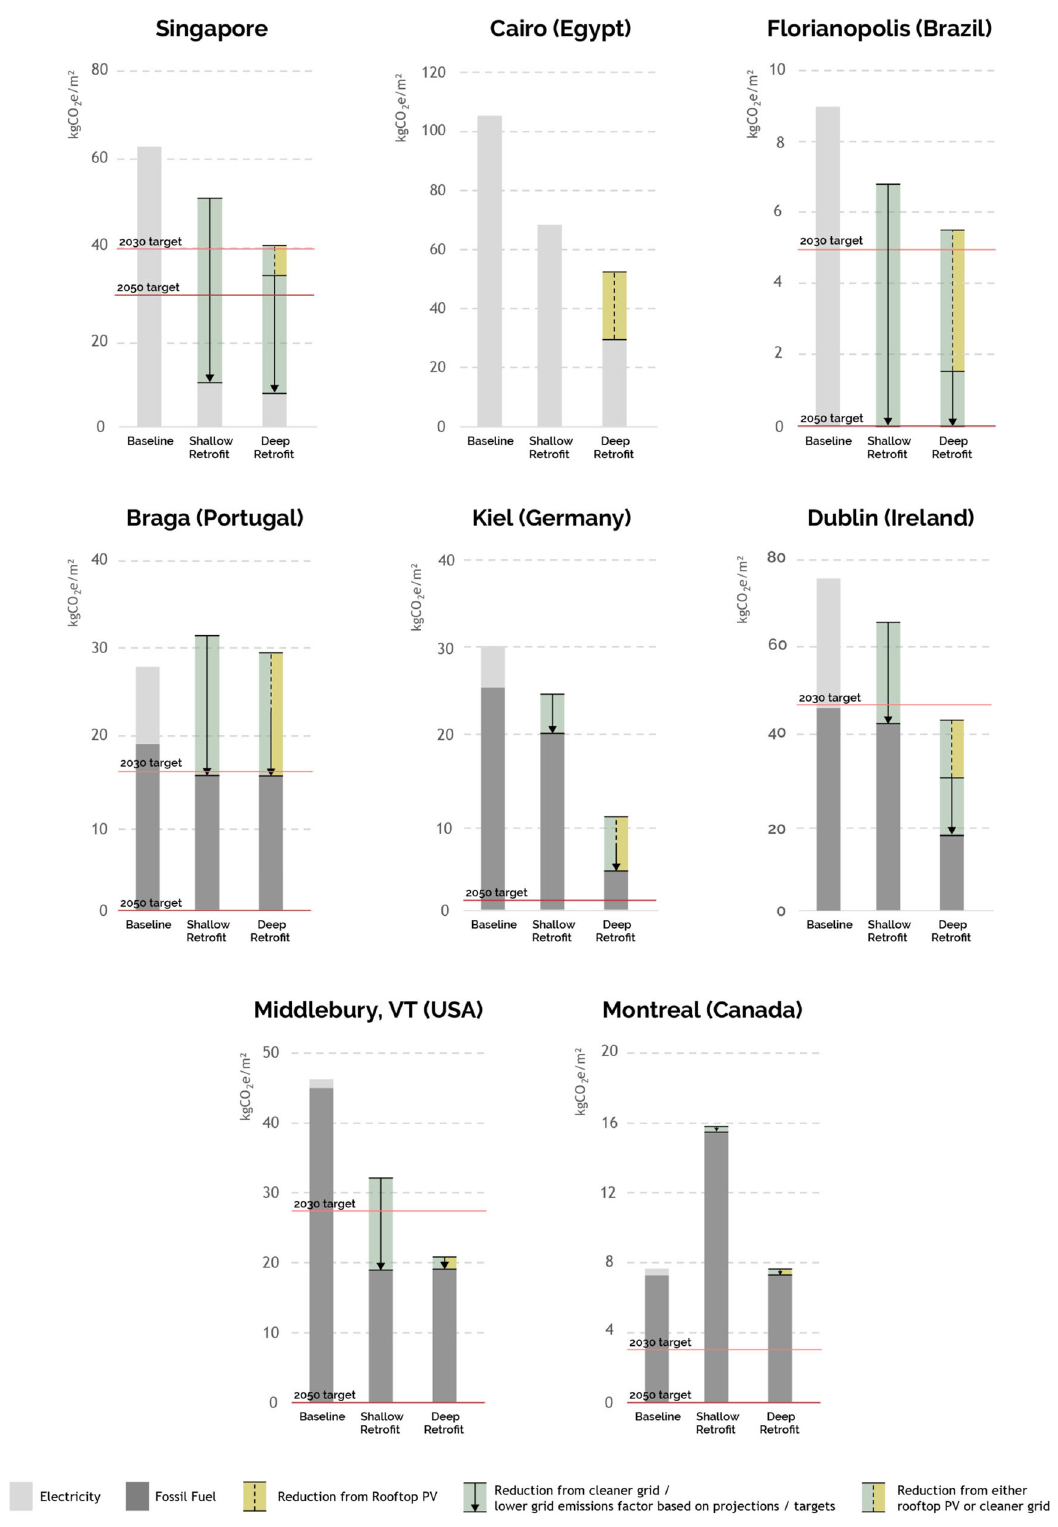
Fig. 4 | Annual carbon emissions (normalized) for baseline, shallow, and deep retro fi t scenarios, with current and projected grid emissions factors and with andwithout100%rooftopphotovoltaicsdeployment. Whereapplicable,carbon